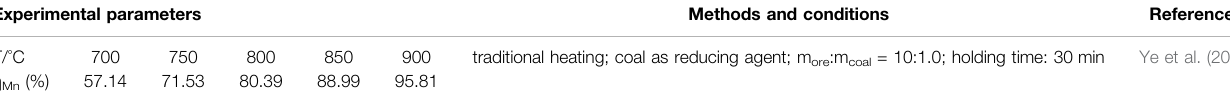
TABLE 2 | Experimental results of traditional heating on manganese reduction ratio. Experimental parameters Methods and conditions